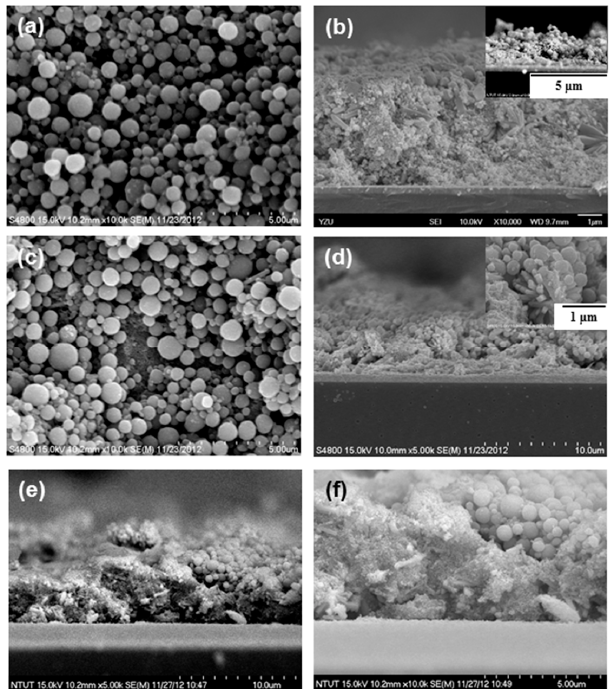
Figure 2. SEM micrographs of ( a ) SNC_Z (1:1) and ( c ) SNC_Z (1:0.5) top views; ( b ) SNC_Z (1:1) and ( d ) SNC_Z (1:0.5) cross ‐ sectional views; ( e ) and ( f ) are the cross ‐ sectional views of the SNC_Z (0.5:1) photoanodes.